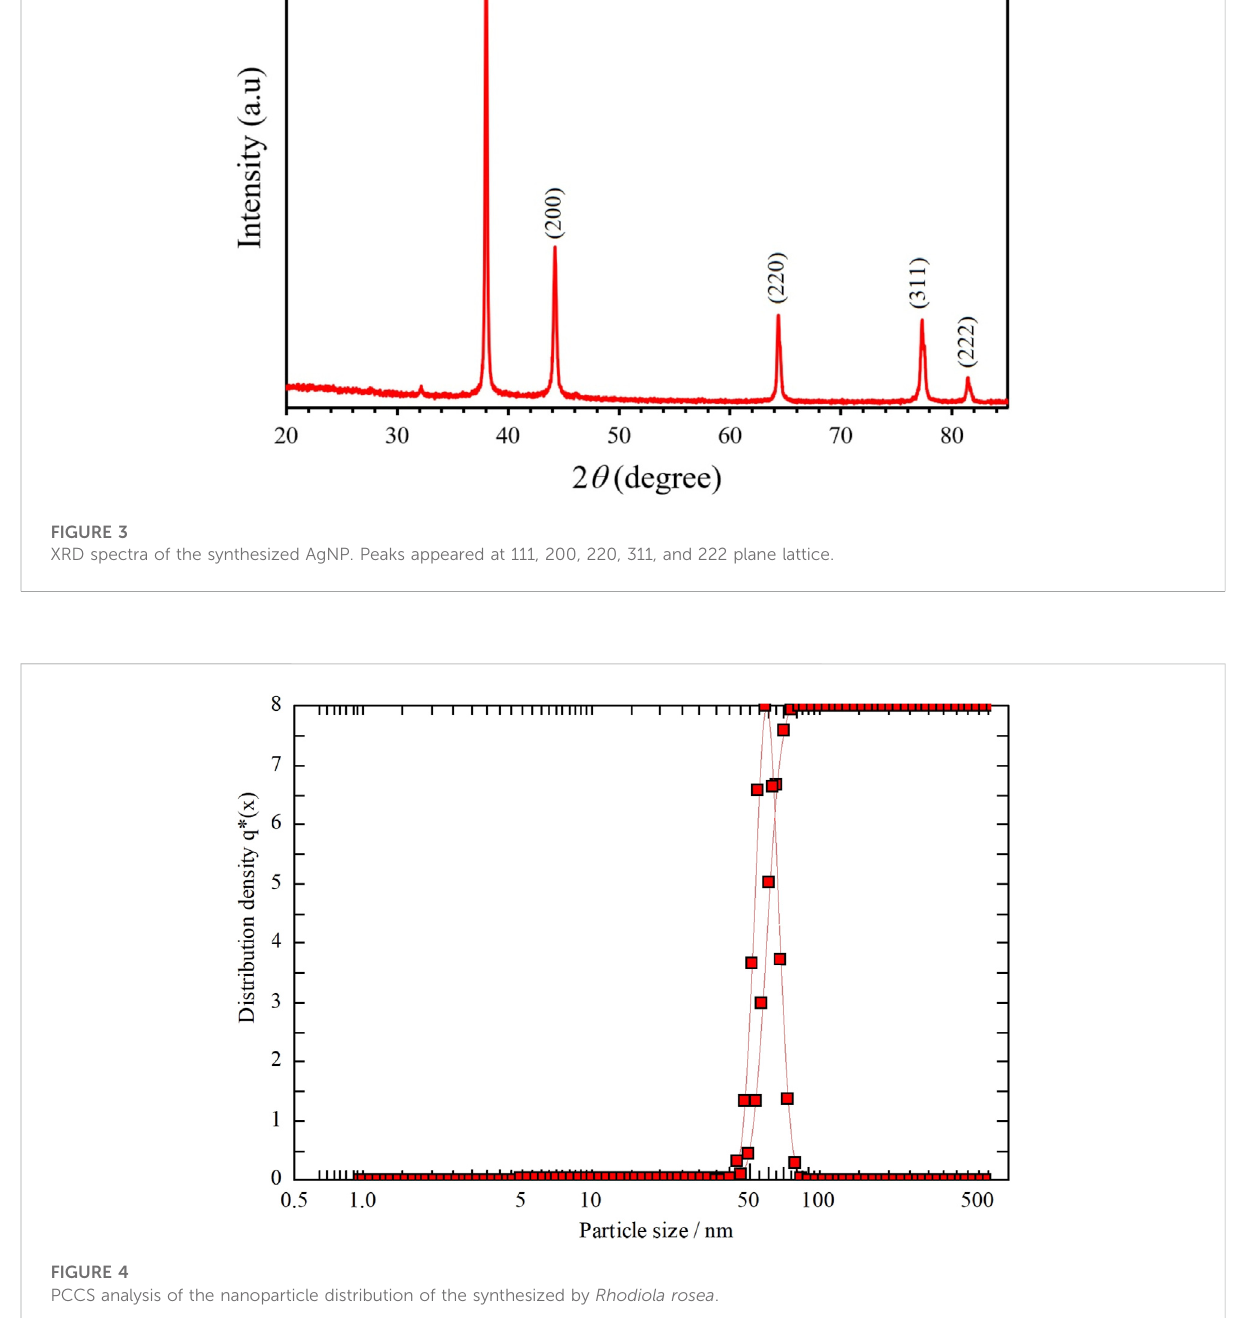
PCCS analysis of the nanoparticle distribution of the synthesized by Rhodiola rosea